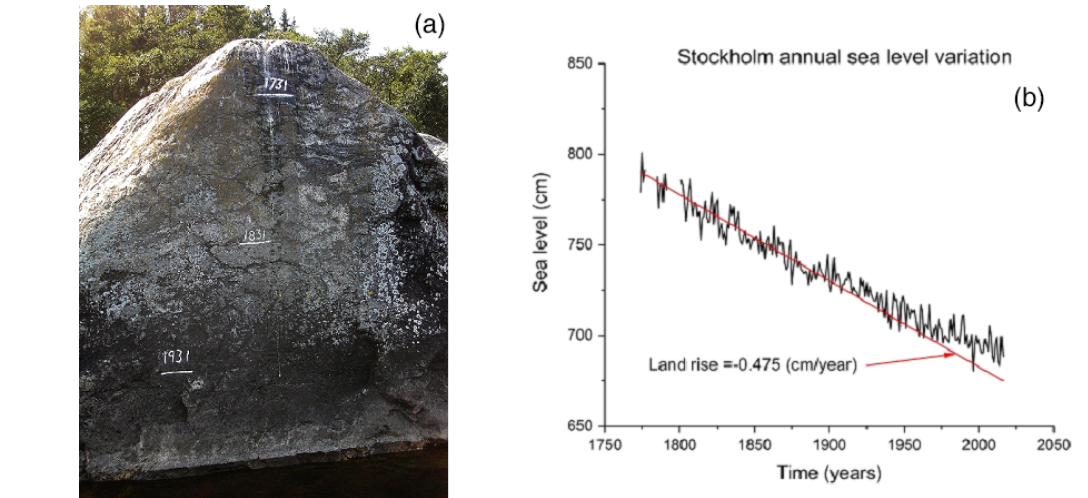
Figure 2. (a) The Celsius seal rock at Lövgrunden outside the Swedish city of Gävle on the Bothnian Sea coast (Ekman, 2016). The present- day water level is about 2m below the 1731 mark (photo courtesy of Martin Ekman). (b) Stockholm annual sea level variations (black) and land rise (red) according to Ekman (2003) (redrawn from Omstedt, 2015).